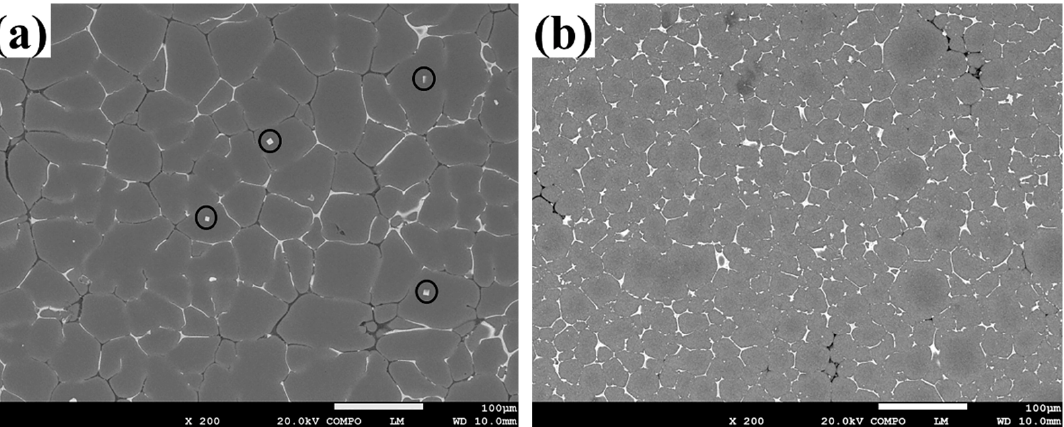
ESMT; ( b ) With ESMT.